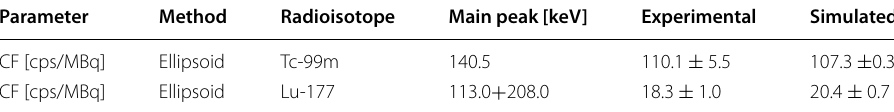
Table 9 Experimental and simulated CF values for 99 m Tc and 177 Lu obtained from acquisitions with the Jaszczak